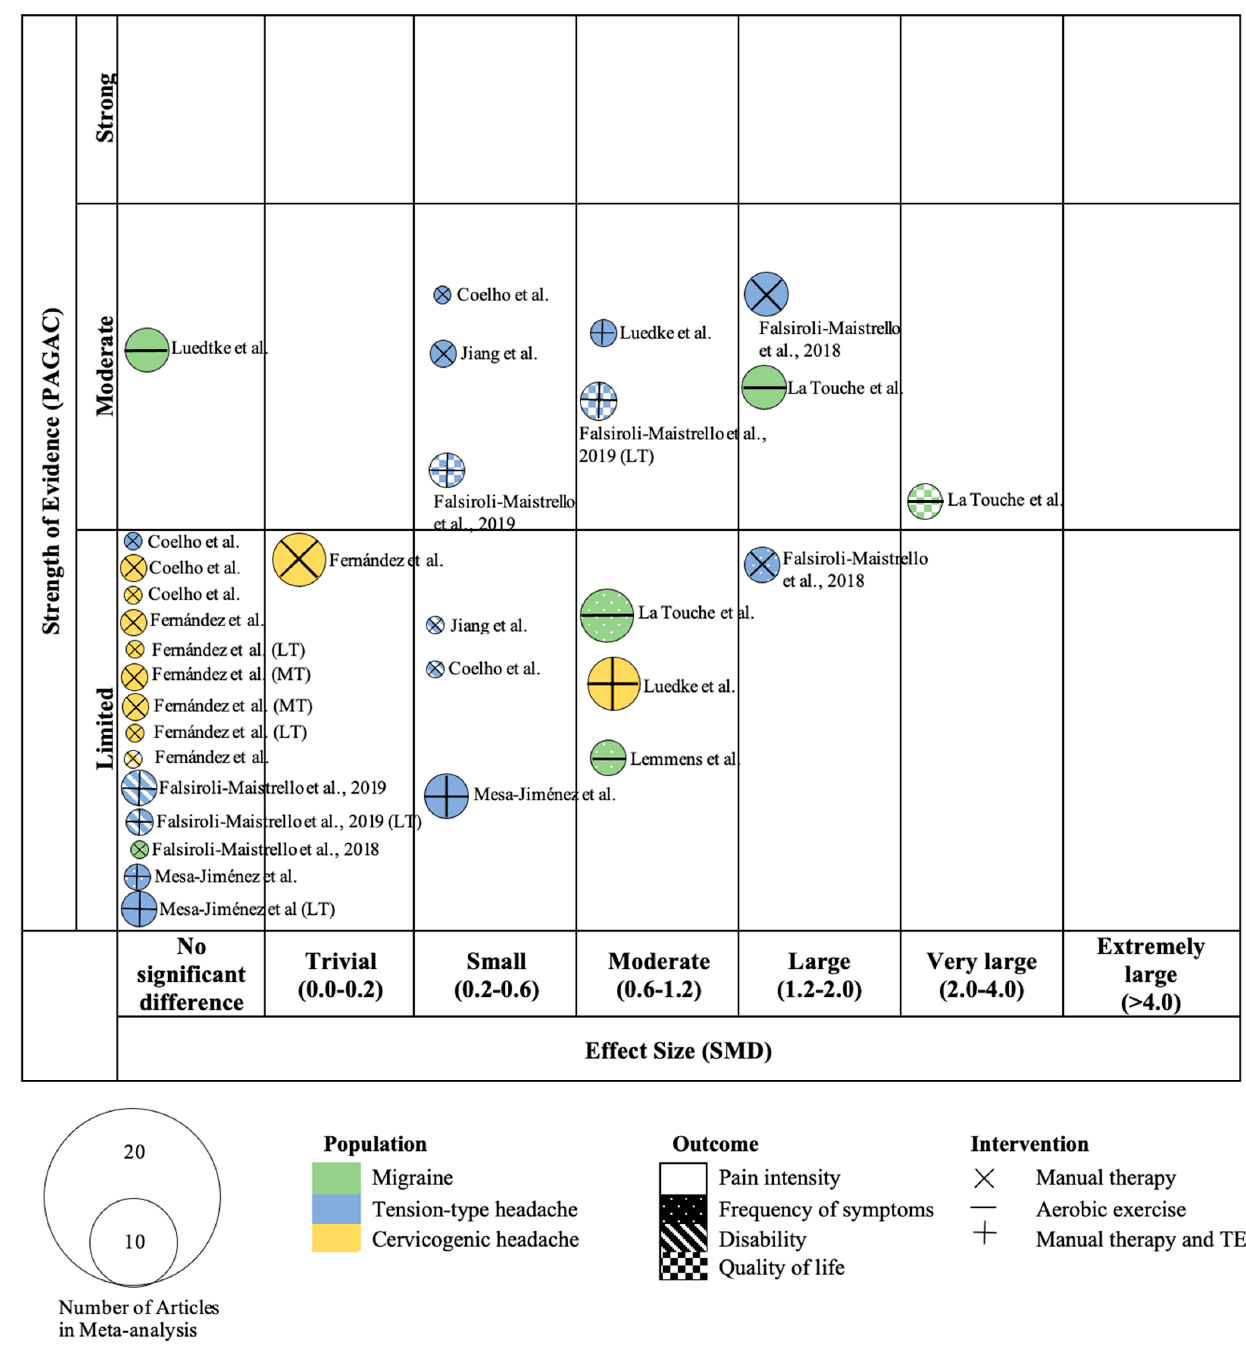
Figure 4. Mapping based on effect size of meta-analyses. TE, therapeutic exercise; MT, mid-term; LT, long-term. On the x -axis the studies are classified according to the effect size of the meta-analysis with standard mean difference (SMD). On the y -axis they are categorized according to the strength of evidence based on the Physical Activity Guidelines Advisory Committee (PAGAC).